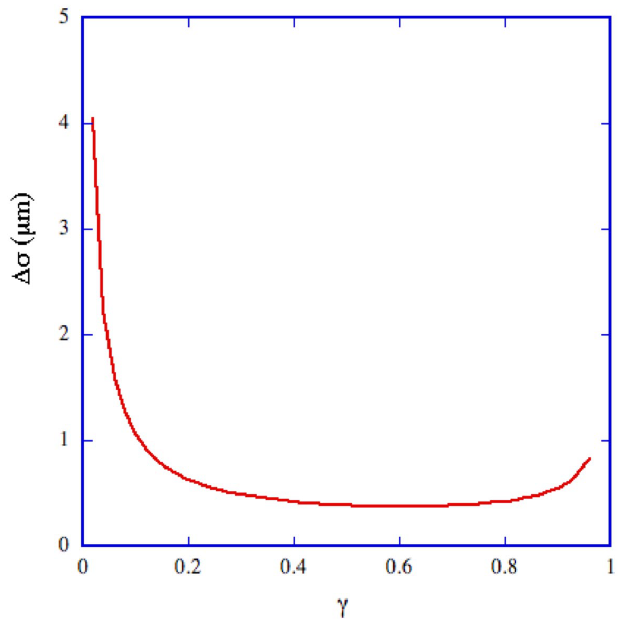
FIG. 2. (Color) Beam size error as a function of (cid:3) , when